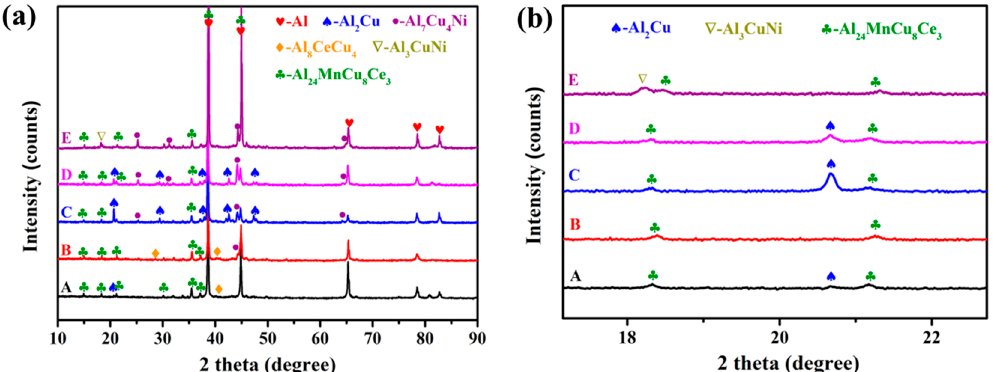
Figure 3. XRD patterns of heat-treated alloys. ( b ) illustrates the enlarged area of ( a ). A, B, C, D, and E represent the 0 Ni, 0.5 Ni, 1.0 Ni, 2.0 Ni, and 4.0 Ni alloys, respectively.